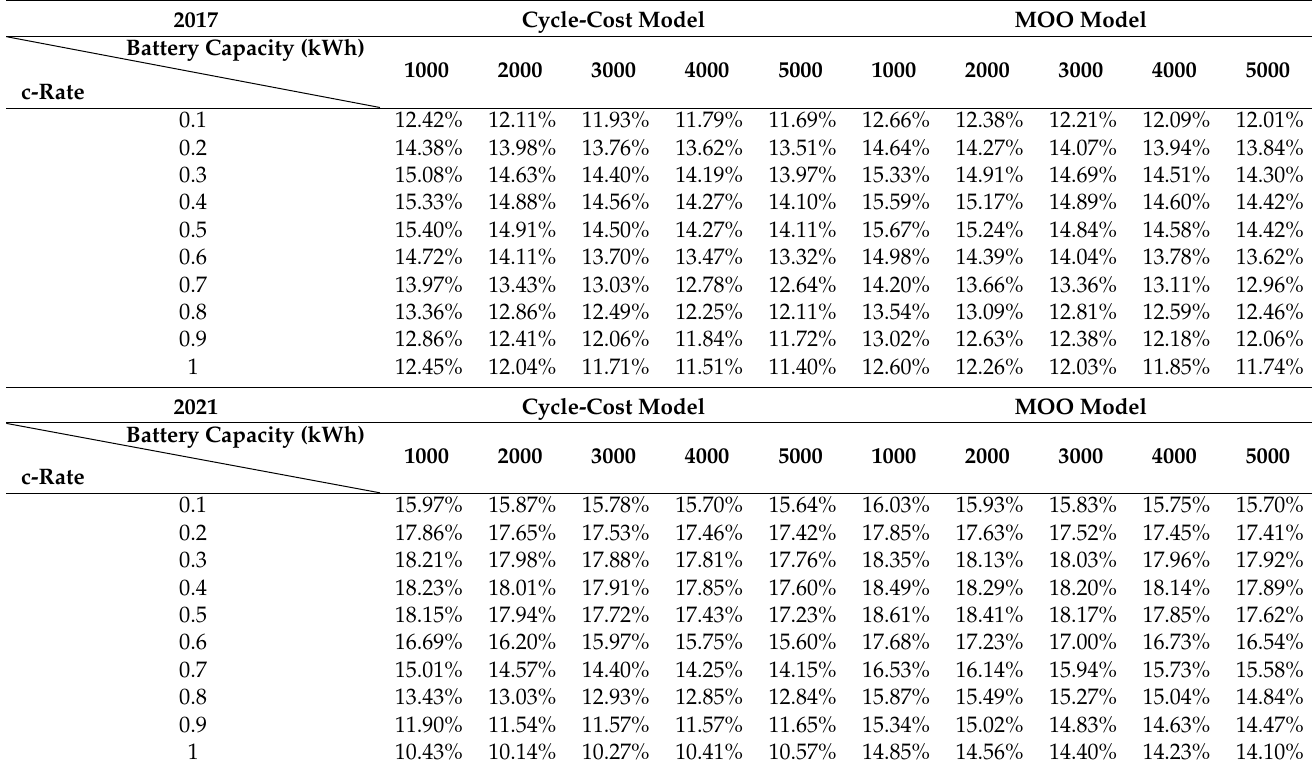
Table 4. Performance comparison (profitability measured by IRR) of CC and MOO for battery capacity price of 100 €